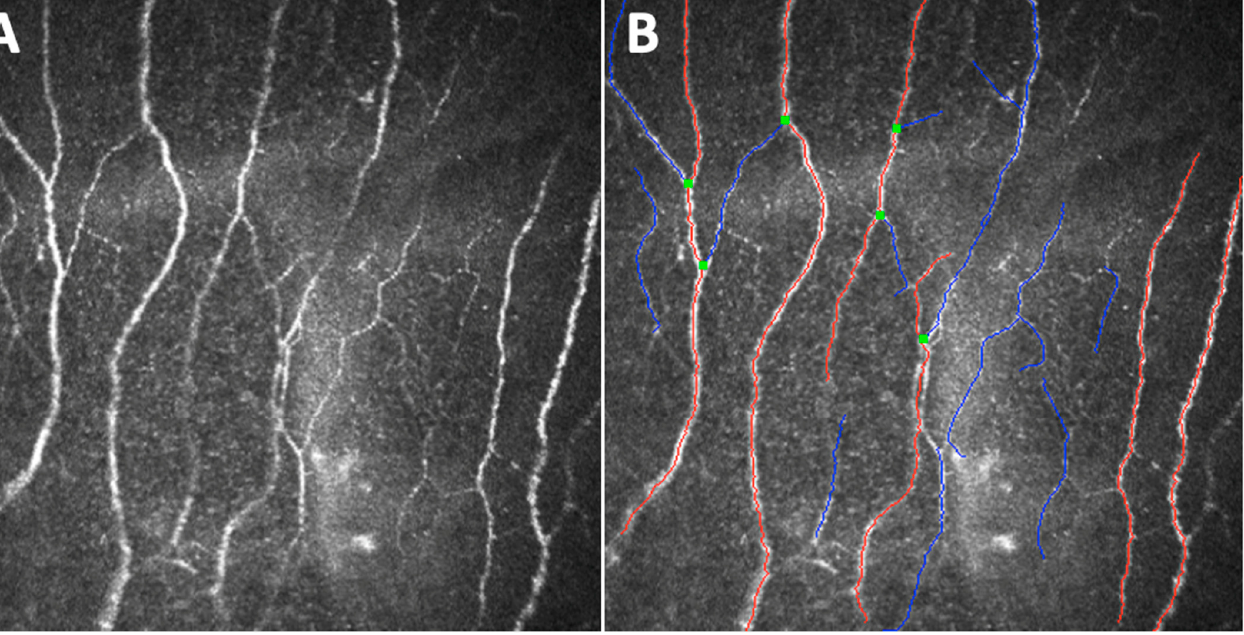
Figure 5. An example of elaboration via ACCMetrics software ( B ) of an image of the sub-basal nerve plexus captured with Heidelberg Retina Tomograph III Rostock Corneal Module (Heidelberg, Germany) from the central cornea of a healthy subject ( A ). The elaborated image shows main fibers in red, branches in blue, and branching points in green.